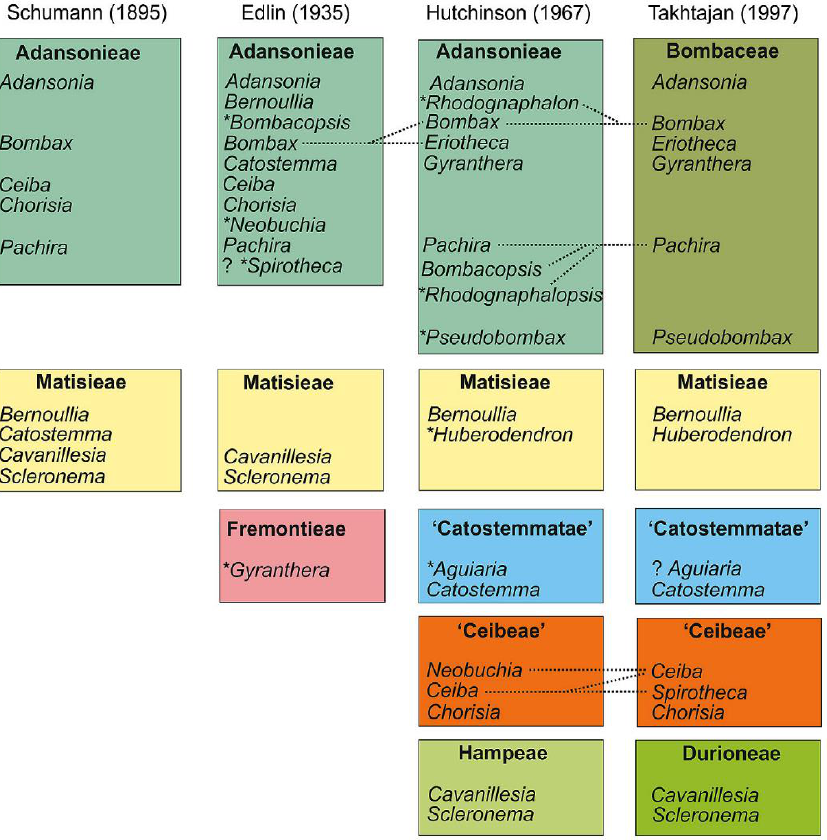
Figure 2. Taxonomic location of Bombacoideae as per different systems of classification. Dotted lines specify the changes in the genus limitation and the genera, which is described after the previ- ous action, and are specified by a symbol (*), while the citation marks represent the tribes which are not validly published. Reproduced with permission from Carvalho-Sobrinho et al. [4] (origi- nally Figure 1).